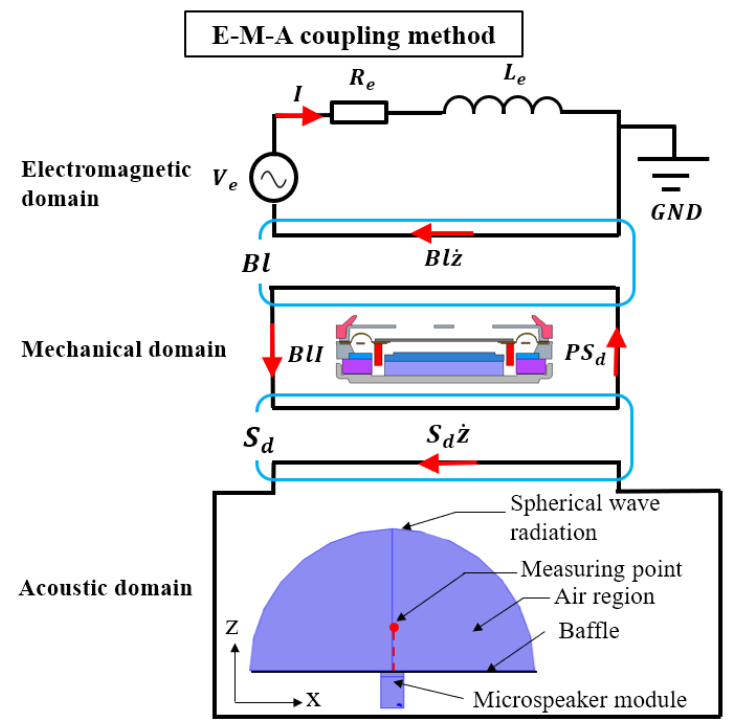
Figure 7. Electromagnetic – mechanical – acoustic coupling model.